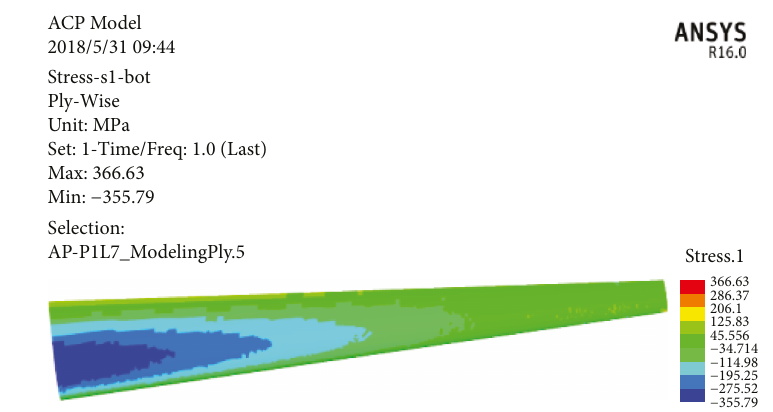
Figure 12: Stress cloud diagram of the upper wing with the layer sequence being [45/0/90/0/-45]